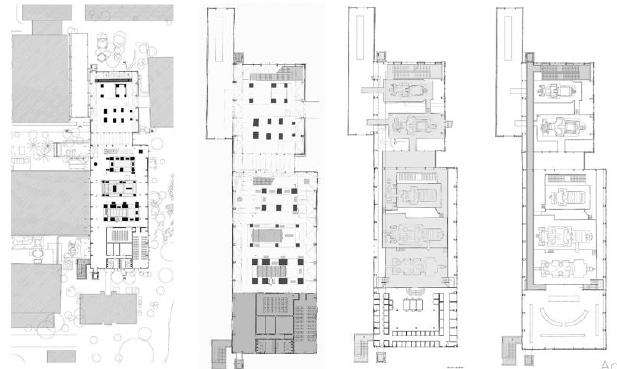
Figure 12. Plans of the Energy Museum.